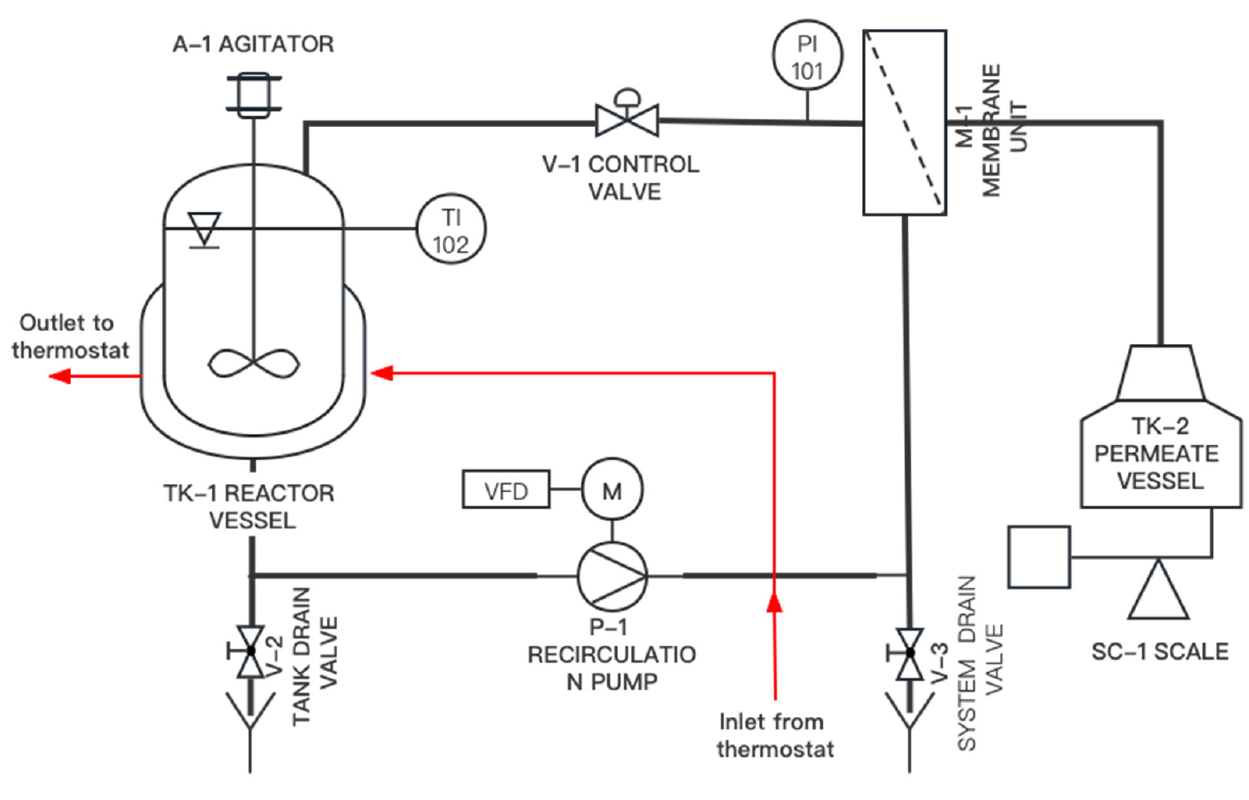
Figure 1. Piping and instrumentation diagram of cyclic enzymatic membrane reactor (cyclic-EMR).